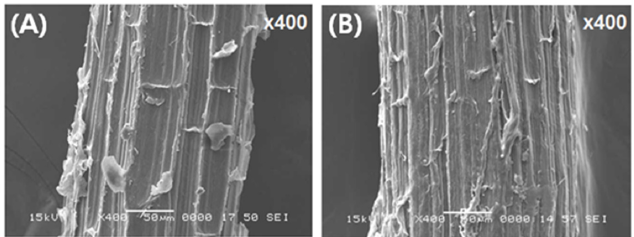
Figure 6. SEM images (×400) showing the henequen fiber surface topography ( A : untreated, B : alkali treated).